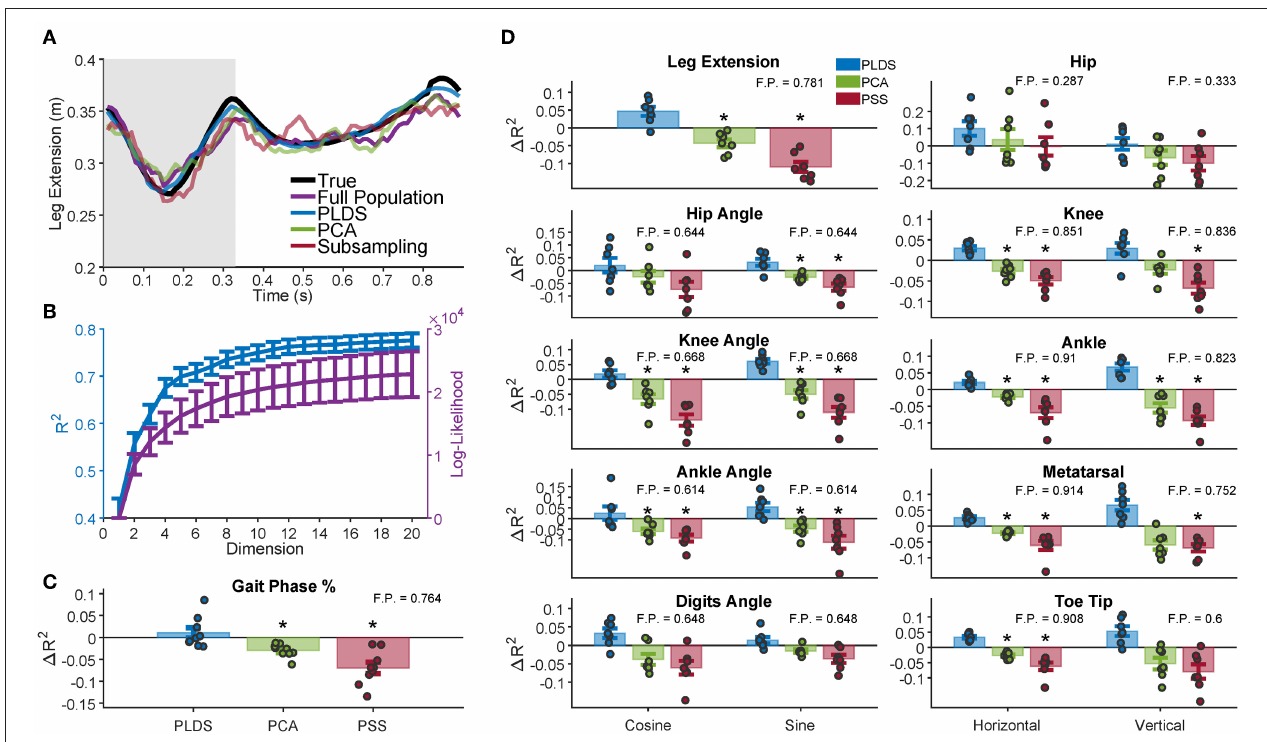
FIGURE 3 | Decoding of leg kinematics and gait phase. (A) A representative example of the limb extension kinematic variable during one gait cycle along with the decoded estimation for the four decoders. Gray background represents the swing period of the gait cycle, white background represents the stance period. In this example, the PLDS decoded signal was the most successful at reconstructing the true signal, with an R 2 of 0.8294, followed by decoding without any dimensionality reduction (Full Population: FP) with an R 2 of 0.5461. PCA and PSS decoding performed the worst, with R 2 of 0.5355 and 0.4980, respectively. The R 2 values for all of the animals and sessions are shown in (D) . (B) Dimensionality analysis for PLDS reveals a plateau in decoding performance (blue) at approximately 12 dimensions for the latent states (plateau defined as when the increase in R 2 <0.001), error bars 1 SEM. Log-likelihood (purple) also plateaus at around 12 dimensions. (C) Cross-validated decoding performance of dimensionality reduction techniques for decoding gait phase percentage. Bars represent the increase in R 2 over the Full Population decoder, with the inset number representing the average R 2 of the Full Population decoder. The full distribution of change in R 2 are displayed as dots over each bar. The PLDS decoder had the highest average R 2 for all the variables. Error bars: 1 S.E.M. Black stars denote significant difference from Full Population decoding R 2 (Wilcoxon Sign Rank Test; Benjamini-Hochberg false discovery rate correction for multiple comparisons, with FDR = 10%). (D) Same as in (C) , except for all analyzed kinematic variables rather than gait phase. Each dot represents a animal/recording session, and the bar plots show the average R 2 with error bars representing 1